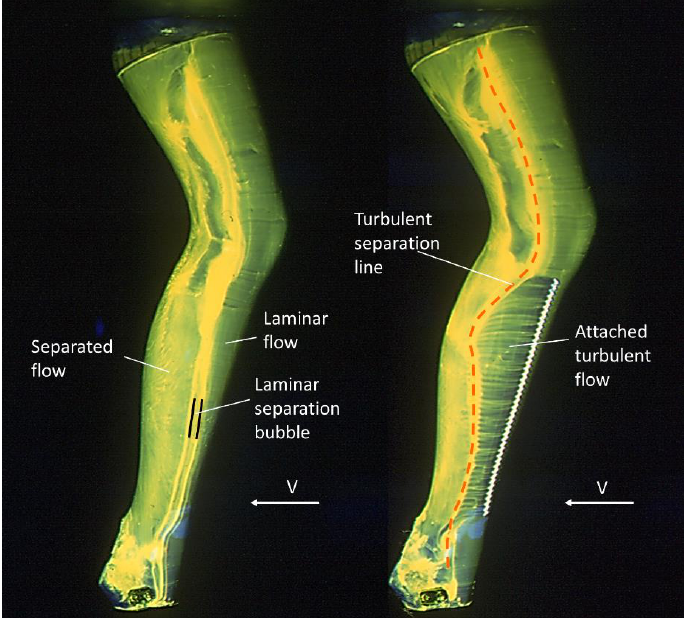
Figure 2. Fluorescent oil flow visualization of the effect of zigzag tape on the separation location on the lower leg. The flow comes from the right. Zigzag-tape thickness in right picture is 0.93 mm .